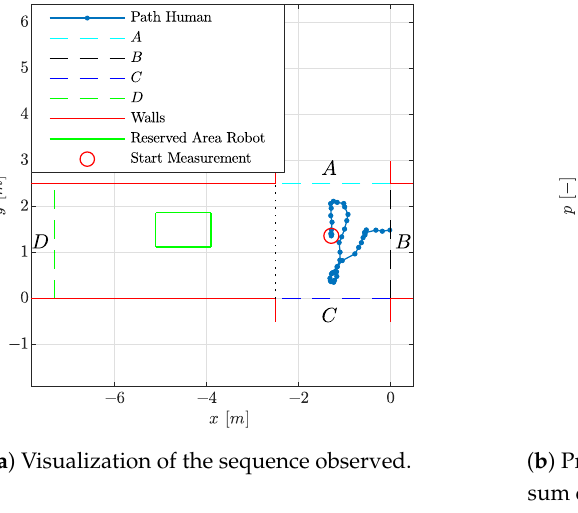
Figure 8. Visualization of the experiment where a person is searching for its